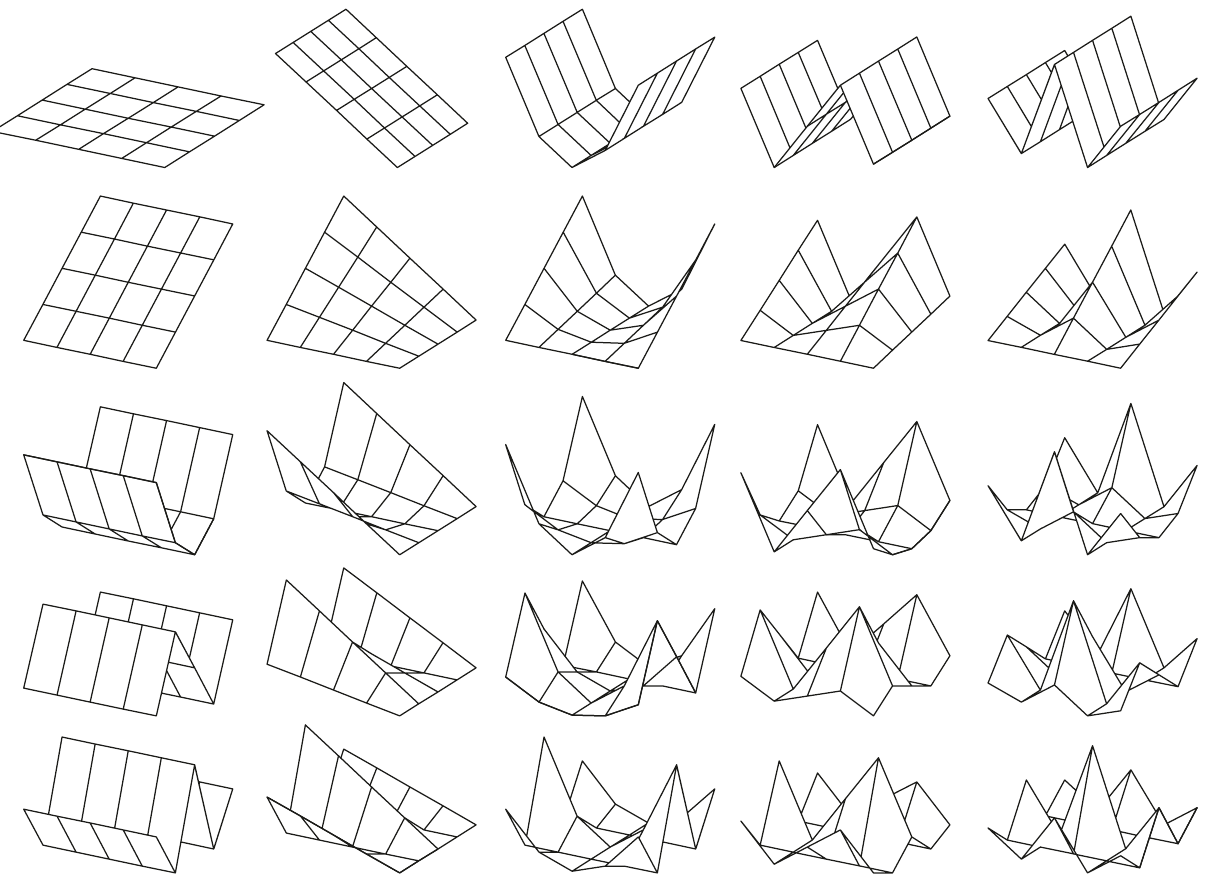
Figure 4: Two-dimensional separable structuring functions.